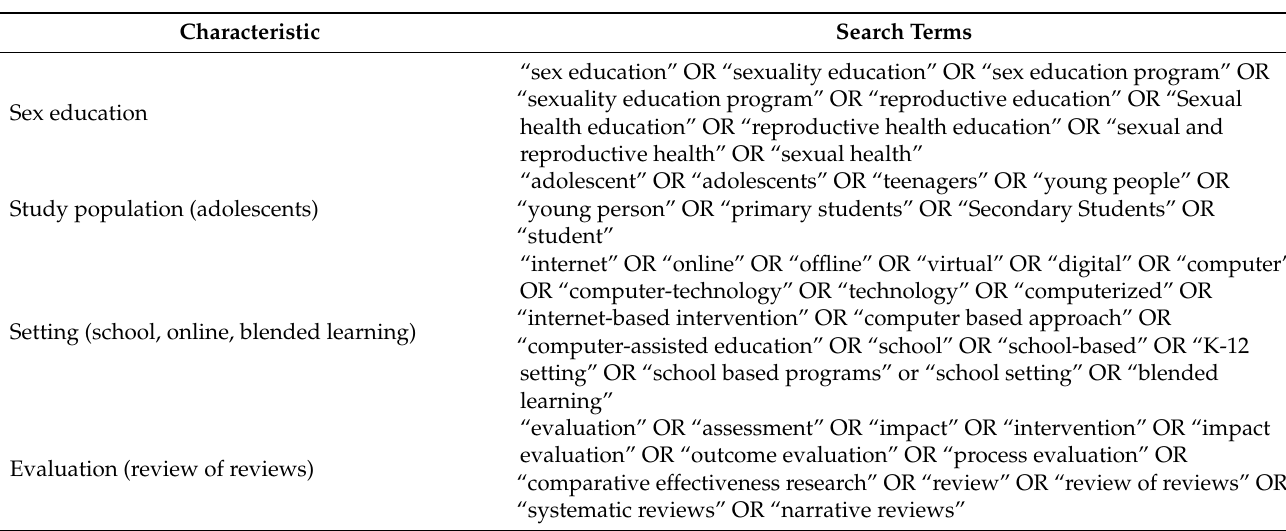
Table A1. Search Terms Used.